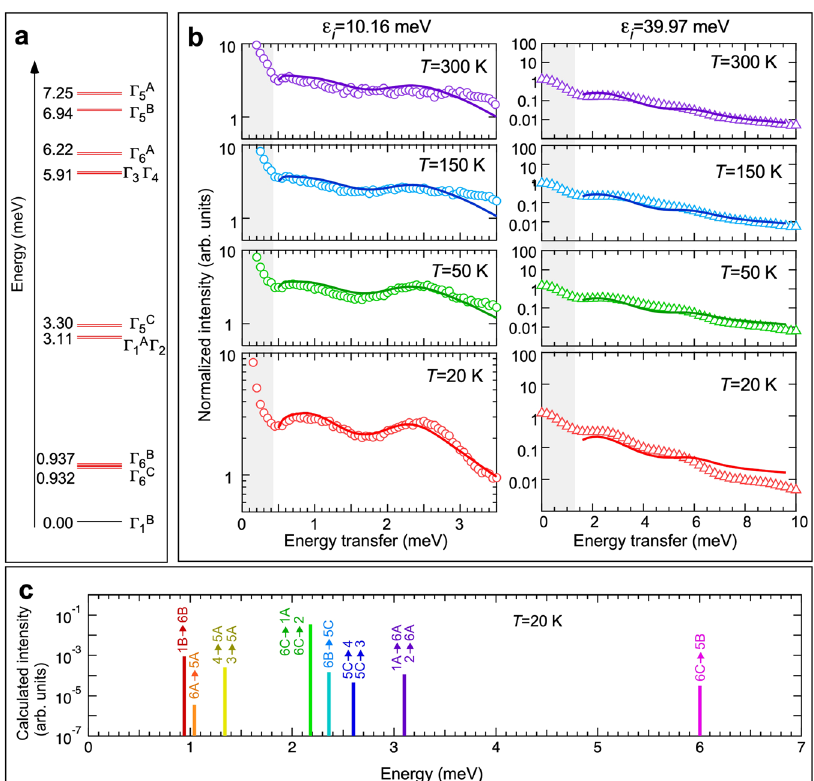
Fig. 3 Comparison of the observed neutron scattering intensity to the theoretical results calculated with the re fi ned CEF parameters in HoB 2 . a The determined CEF level scheme of HoB 2 . The single and double lines denote the singlet and doublet CEF levels, respectively, b comparison of the neutron scattering intensity between observation and calculation. The circle and triangle symbols denote the observed data for ϵ i = 10.16 meV and ϵ i = 39.97 meV. The solid lines are theoretical curves calculated by eq. (4) with the re fi ned CEF parameters described in the main text. These curves were convoluted by the experimental resolution function, and c calculated neutron intensities (expressed by eq. (4)) for energy corresponding to each transition between two states at T = 20